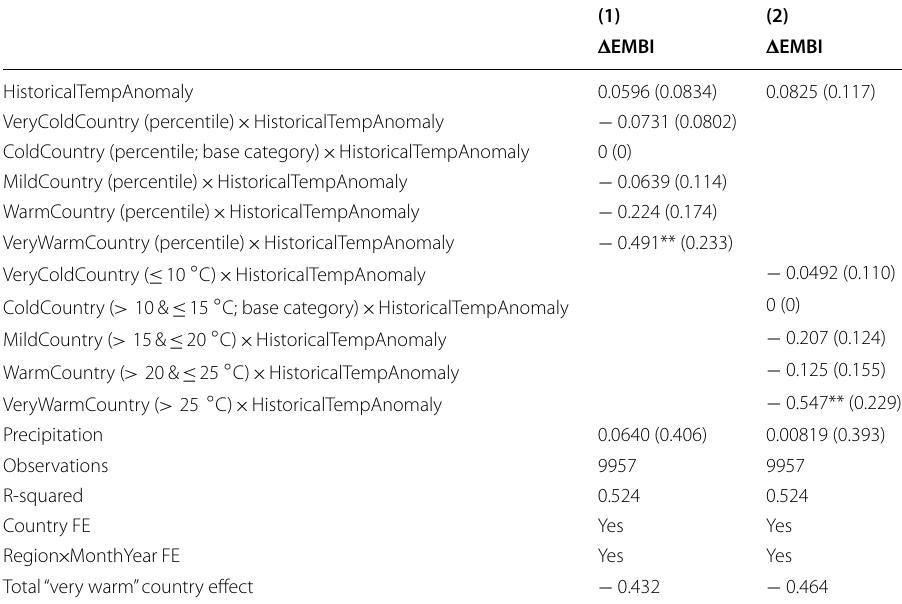
This table shows OLS estimation results of a panel of 54 countries from 1994m1 to 2018m12. (cid:31) EMBI are monthly natural log returns of a country’s EMBI index. HistoricalTempAnomaly is the difference between monthly temperature of a country and its 1901–1950 temperature average of the same month. Each country is grouped into a bin either according to percentiles or 5 ◦ C intervals (see Table 5 for country classification). One bin is omitted due to multicollinearity (base category). Single terms of the bins are subsumed by time fixed effects. Total “very warm” country effect is the sum of the VeryWarmCountry interaction and the single term of HistoricalTempAnomaly. Standard errors (in parentheses) are clustered at the